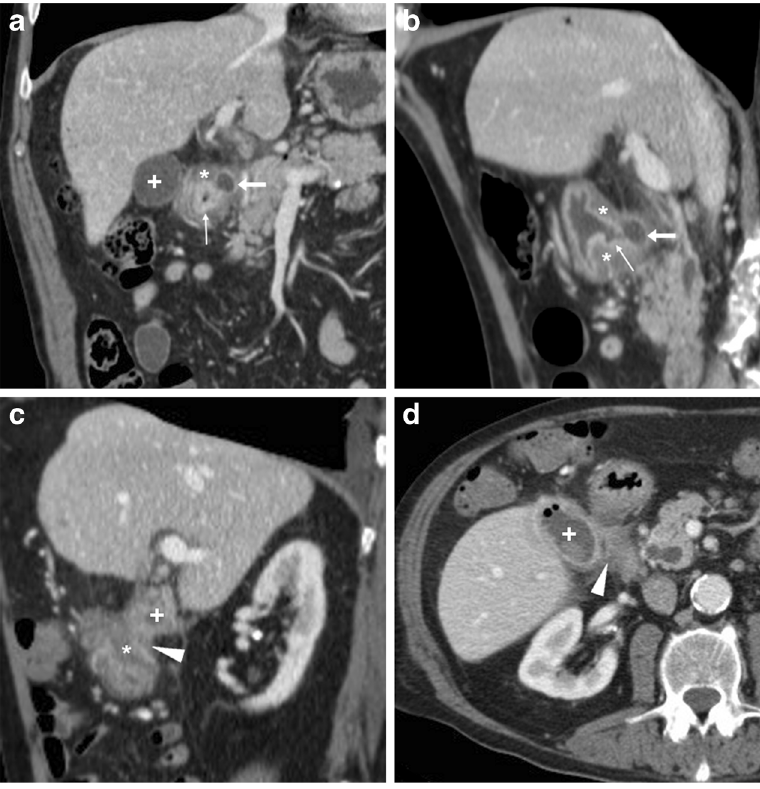
Fig. 18 A 78-year-old male with history of chronic NSAID use had initial contrast-enhanced CT ( a, b ) finding of circumferential thickening of pylorus and proximal duodenum with oedematous submucosa (*), enhancing mucosa (thin arrows) and posterior ulcer outpouching (arrows); ventrally, the normal- appearing gallbladder (+) was in contact with theaffectedduodenal bulb. Fifteen months later, the patient experienced melaena and abdominal pain: repeated CT ( c, d ) showed development of communication (arrowheads) between thickened duodenum (*) and contracted gallbladder (+) with intraluminal air and some dependent sludge or